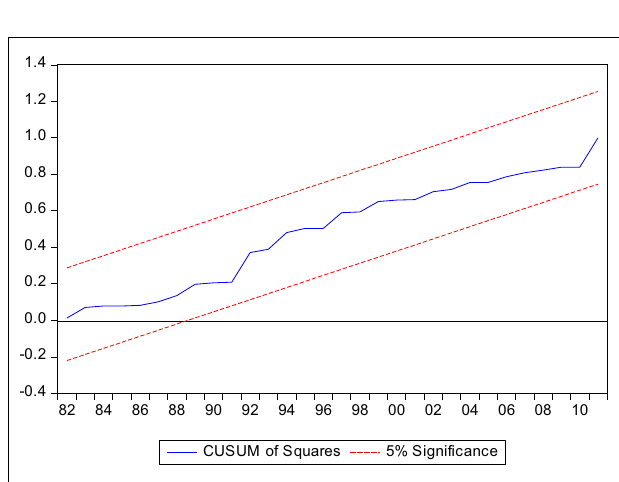
FIGURE 2 | Plot of CUSUM .